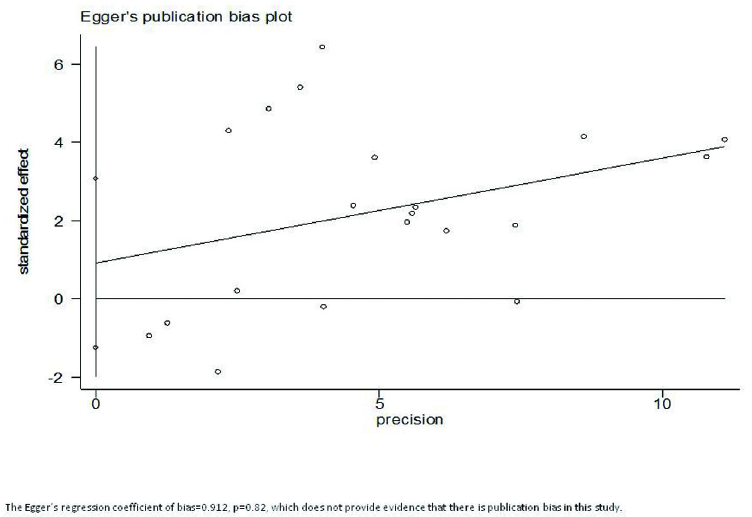
Figure 6. Egger’s publication bias plot.